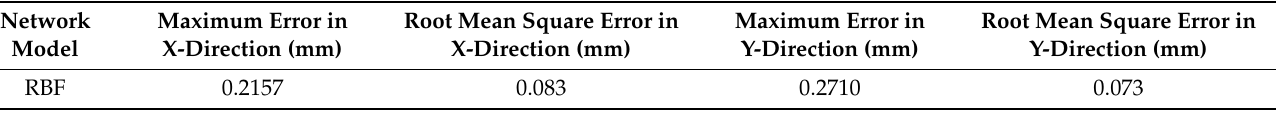
Table 7. Final test results.